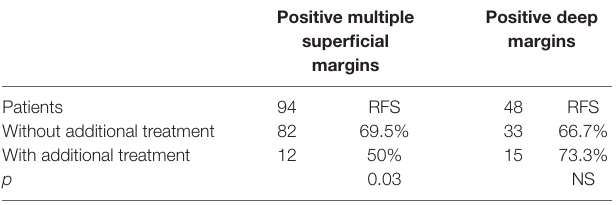
FigUre 4 | Kaplan–Meier curves showing recurrence-free survival in relation to margin status for each group of patients. MS, positive multiple superficial margins; SS, positive single superficial margin; “ + ” symbol, censored observations. Table 3 | Five-year disease-specific survival (DSS), recurrence-free survival Table 4 | Impact of additional treatments in all patients on (RFS), and organ preservation (OP) for the entire cohort, and for Groups A and B.